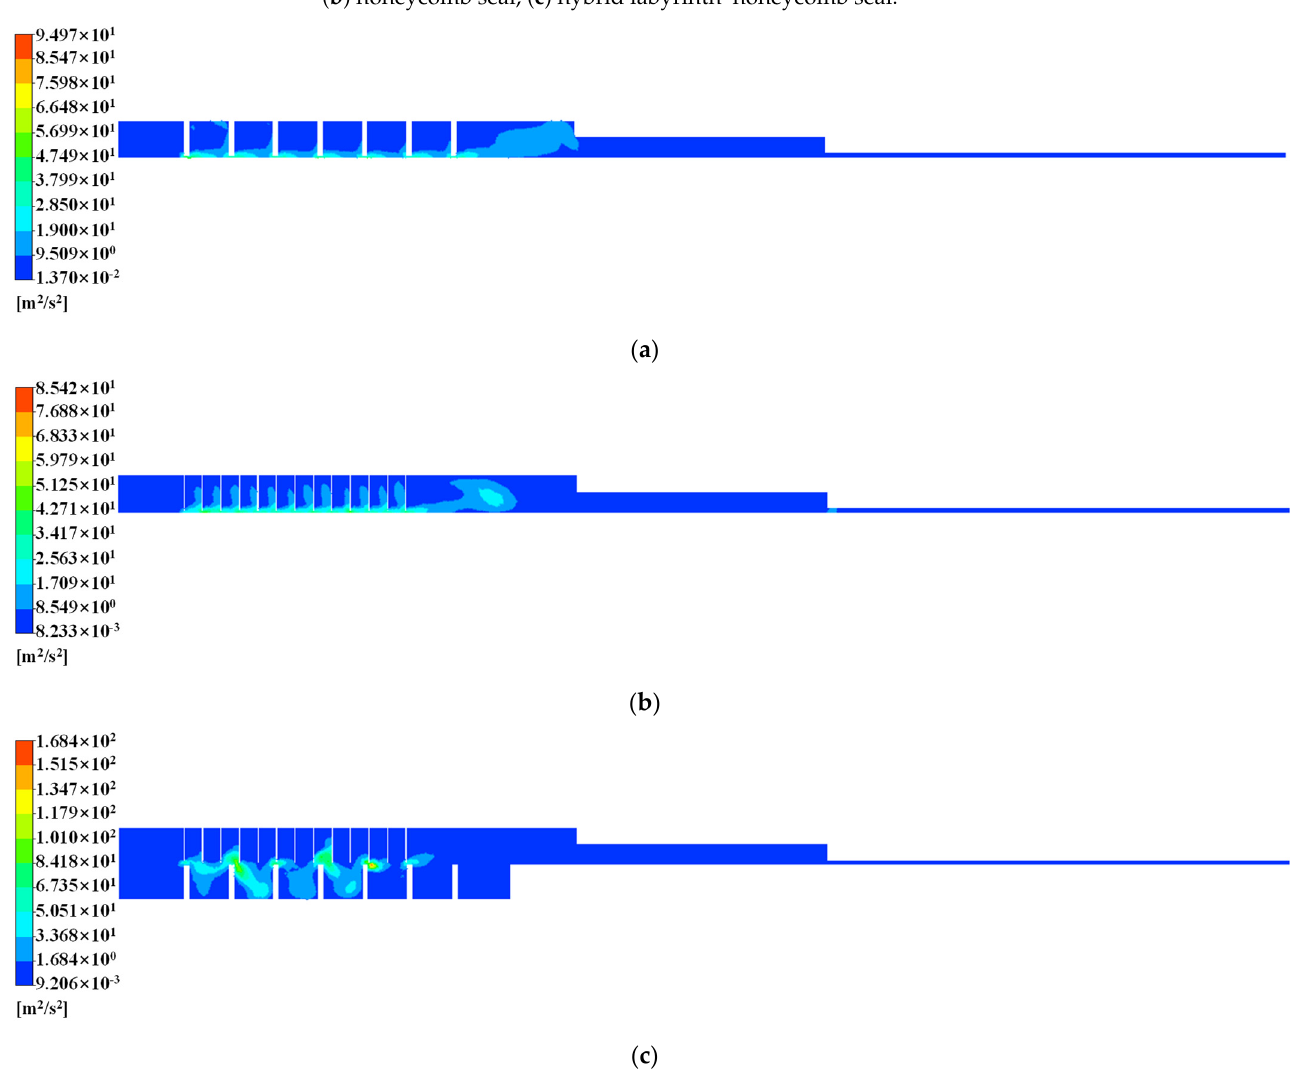
Figure 9. Pressure distribution diagram of three types of seals (REL = 0.1 mm). ( a ) Labyrinth seal; ( b ) honeycomb seal; ( c ) hybrid labyrinth–honeycomb seal.